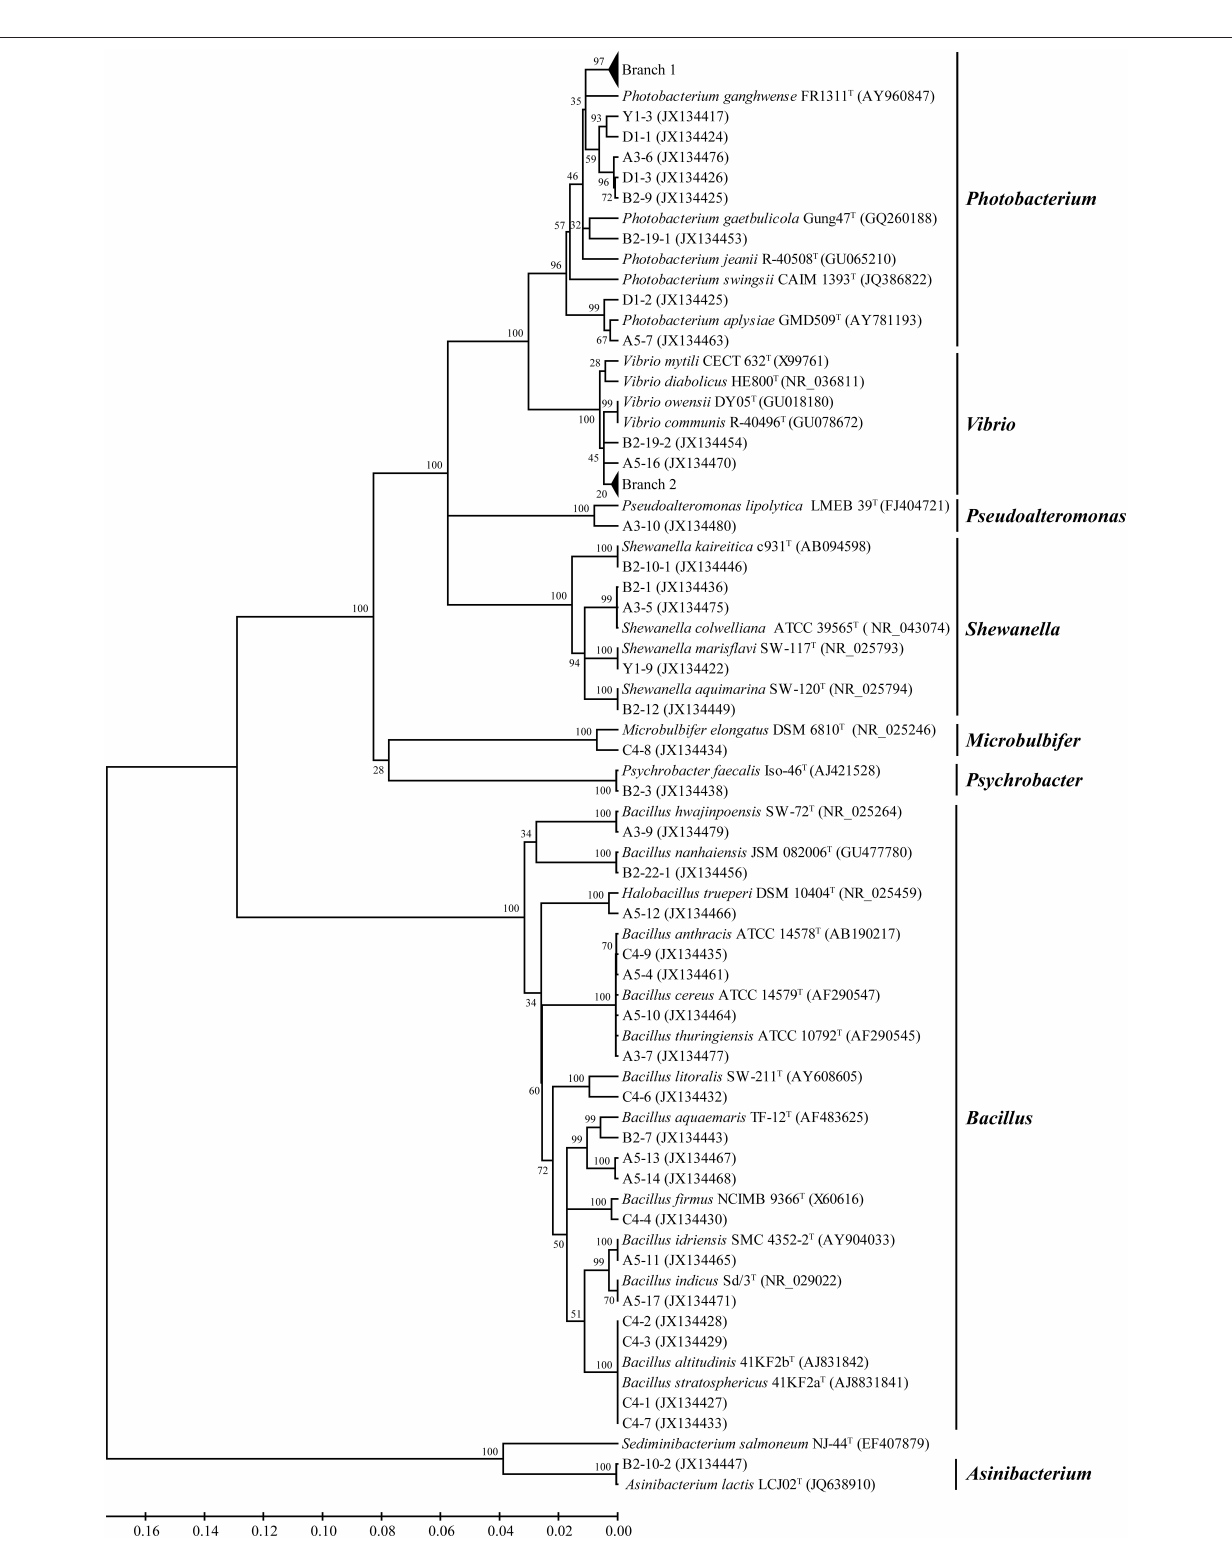
FIGURE 3 | Neighbor-joining tree of the protease-producing bacteria isolated from six stations in Jiaozhou Bay based on their 16S rRNA gene sequences. Branch 1 indicates 18 Photobacterium strains closely related to Photobacterium sp. MA1-3 (JQ315889); Branch 2 indicates 11 Vibrio strains closely related to Vibrio alginolyticus